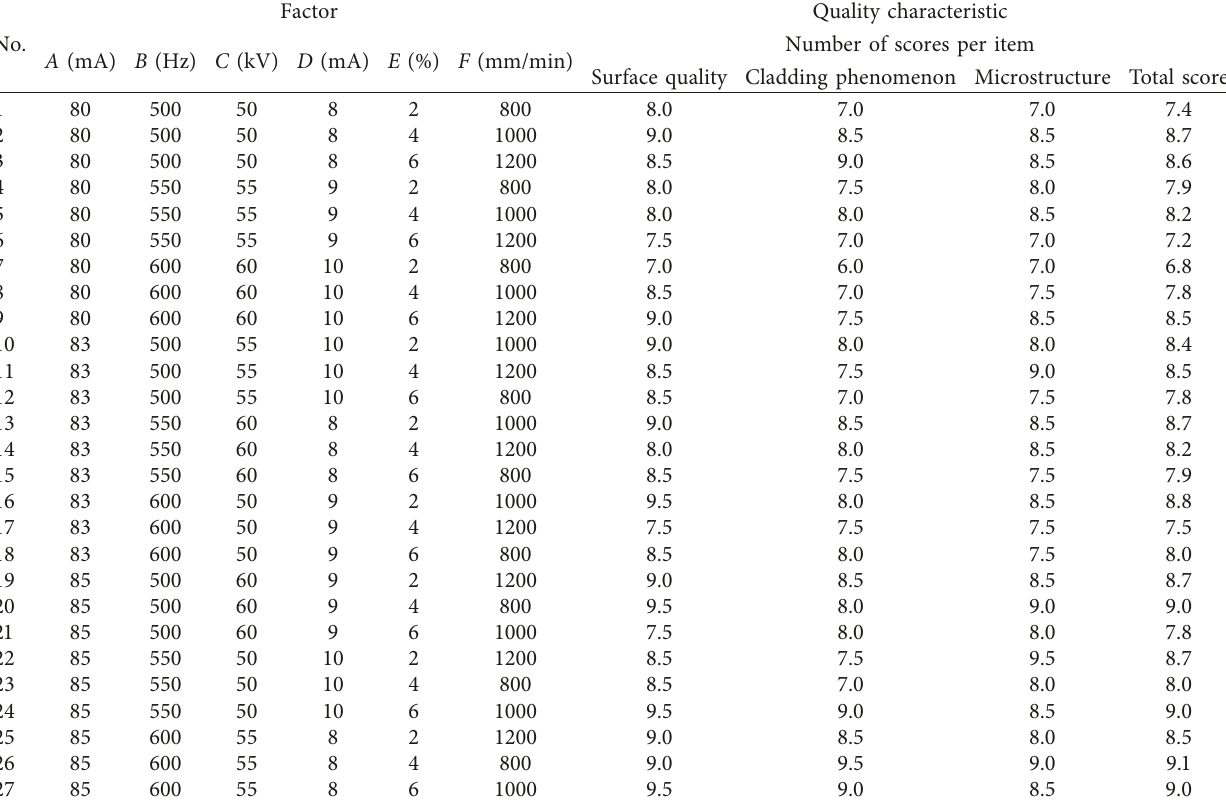
Table 4: WC-CoCr orthogonal experiment results.